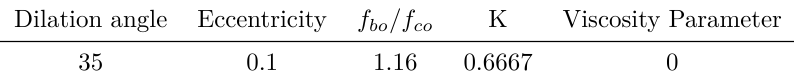
Table 1. Concrete Damage Plasticity